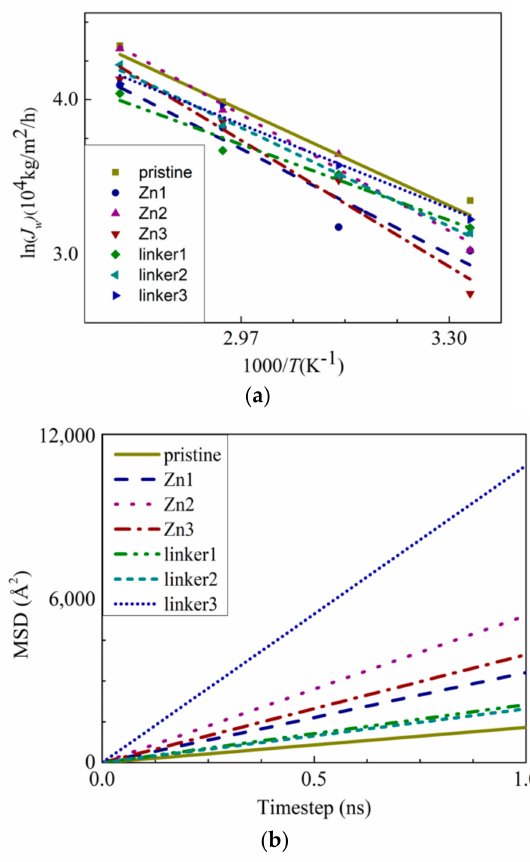
Figure 10. ( a ) The Arrhenius plots of the water flux J W and ( b ) MSDs of the water molecules inside the feed